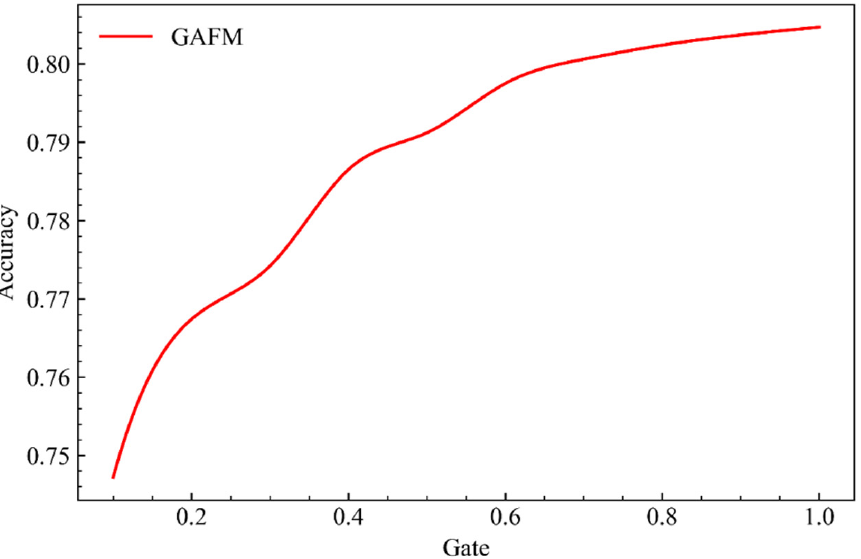
Figure 5. Prediction accuracy of GAFM under the influence of g value. (2) The second is the experimental effect on dataset 2, which is the Movielens dataset with the size of 1